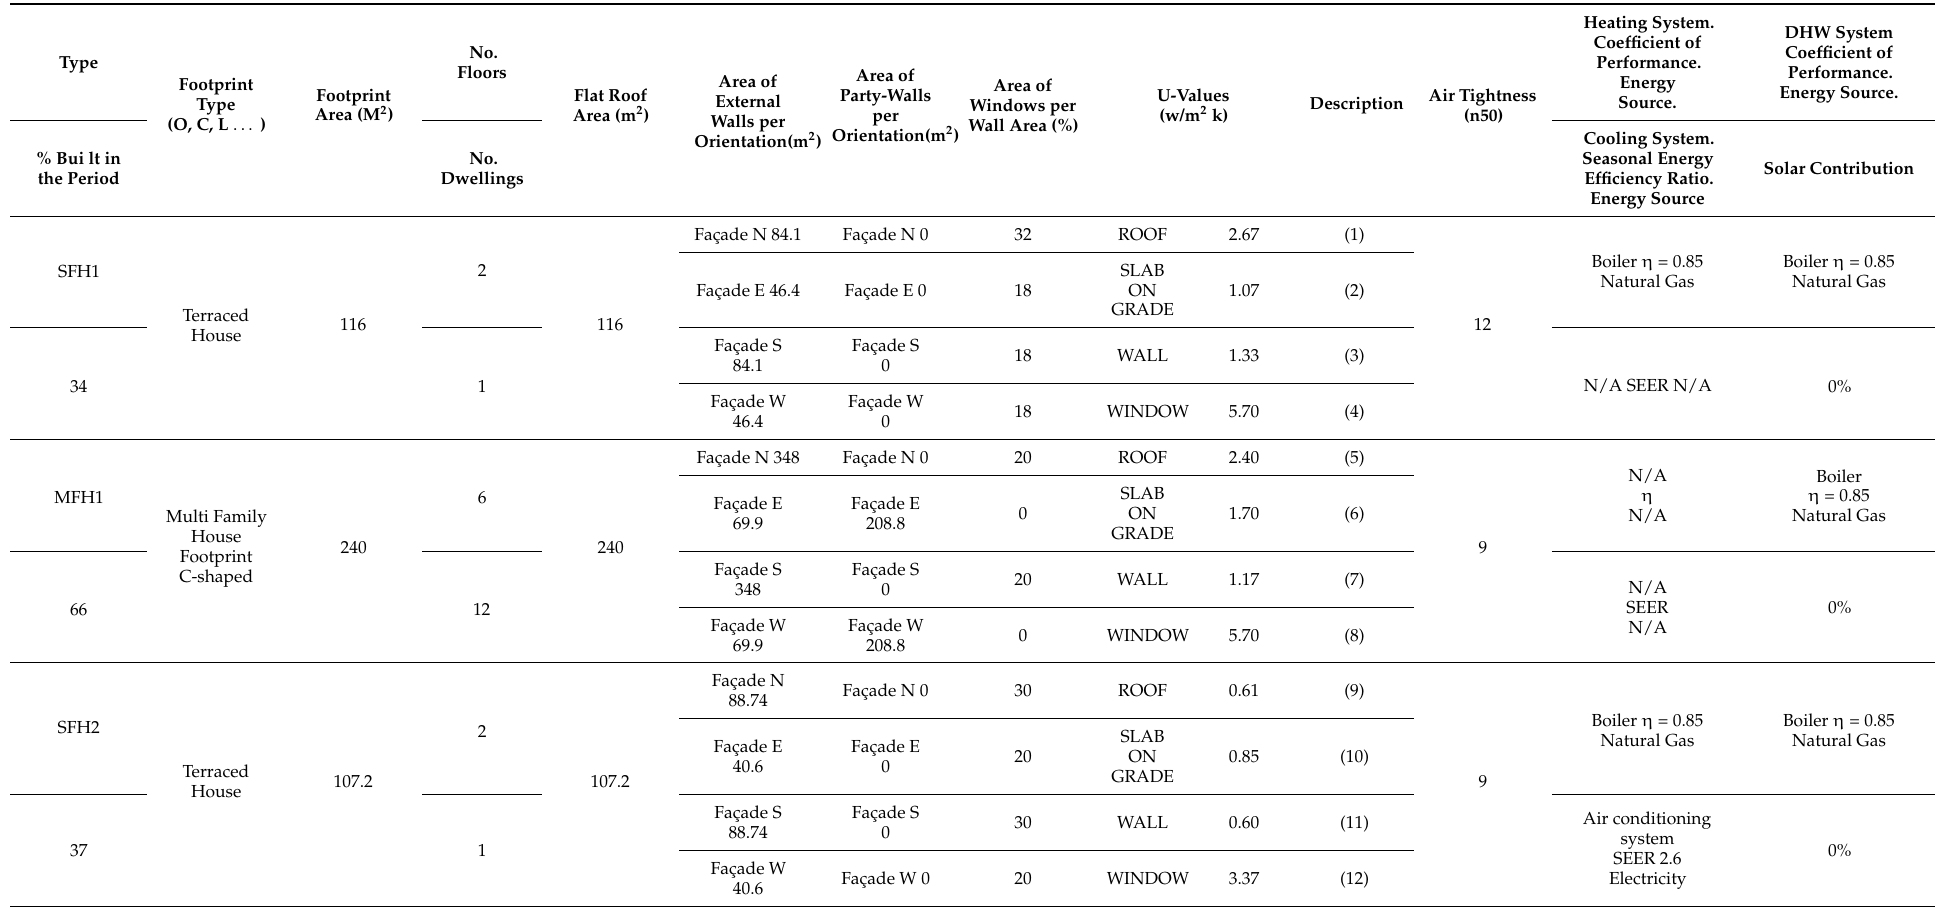
Table A14. Thermal and geometrical characteristics for the reference buildings in Spain (SF1, SFH2, SFH3 and MFH1, MFH2,